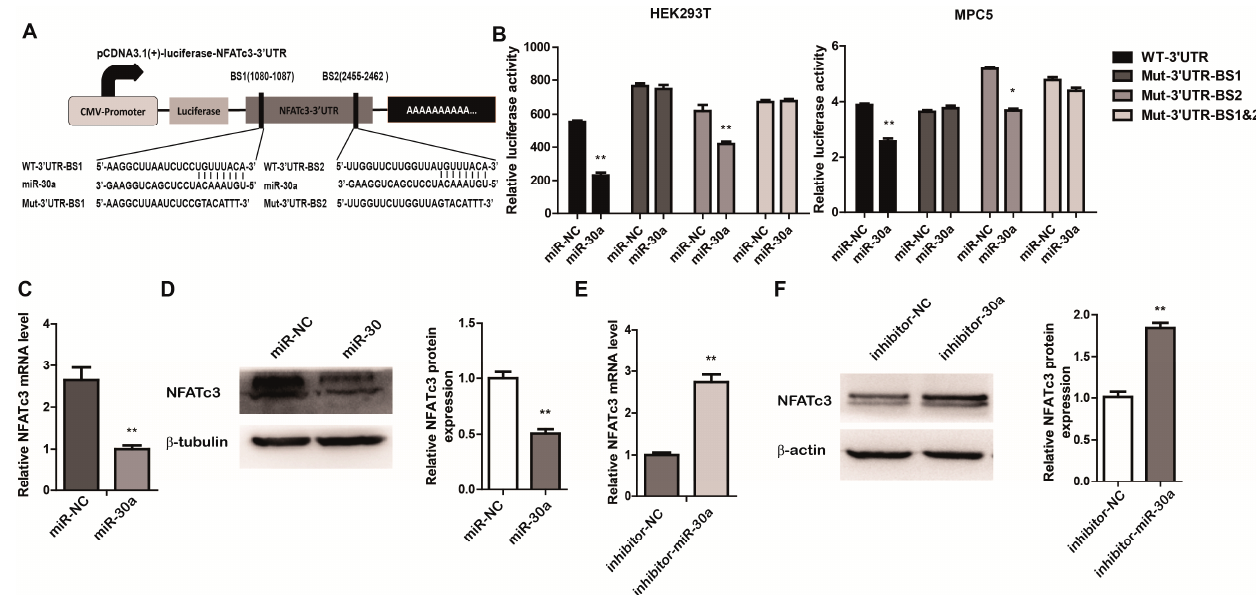
Figure 3. MiR-30a Targets the 3 ʹ UTR of NFATc3 and Inhibit the Expression of NFATc3. ( A ) Schematic presentation of two binding sites of miR-30a in the 3 ʹ UTR of NFATc3 and NFATc3 3 ʹ UTR reporter constructs, including wild type and mutant vectors; ( B ) Dual-luciferase reporter assays demonstrate that the wild-type and mutation-BS2 reporter of NFATc3 3 ʹ UTR suppressed activity in HEK293T cells and MPC5 cells transiently transfected with miR-30a, but not in mutation-BS1 and mutation-BS 1 and 2; ( C ) RT-qPCR and ( D ) Western blot analysis of NFATc3 expression levels in cultured MPC5 cells transfected with miR-30a (30 nM) or miR-NC. Quantitative analysis of NFATc3 protein level after normalization with β -tubulin; ( E ) RT-qPCR and ( F ) Western blot analysis of NFATc3 expression levels in cultured MPC5 cells transfected with inhibitor-30a (50